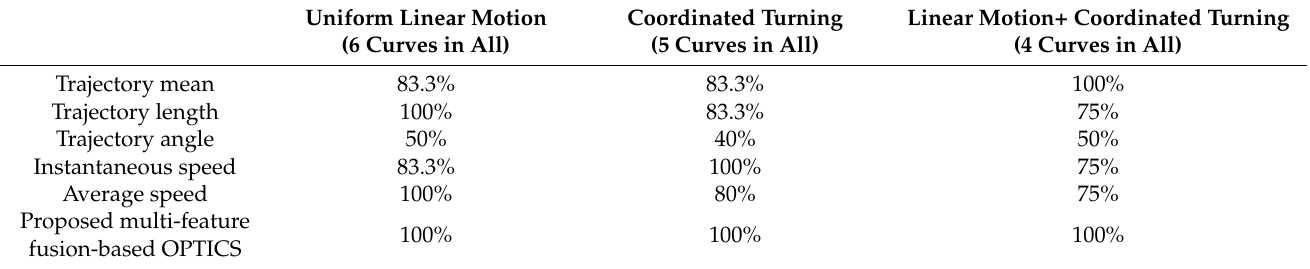
Table 1. Two-dimensional coordinate system trajectory clustering